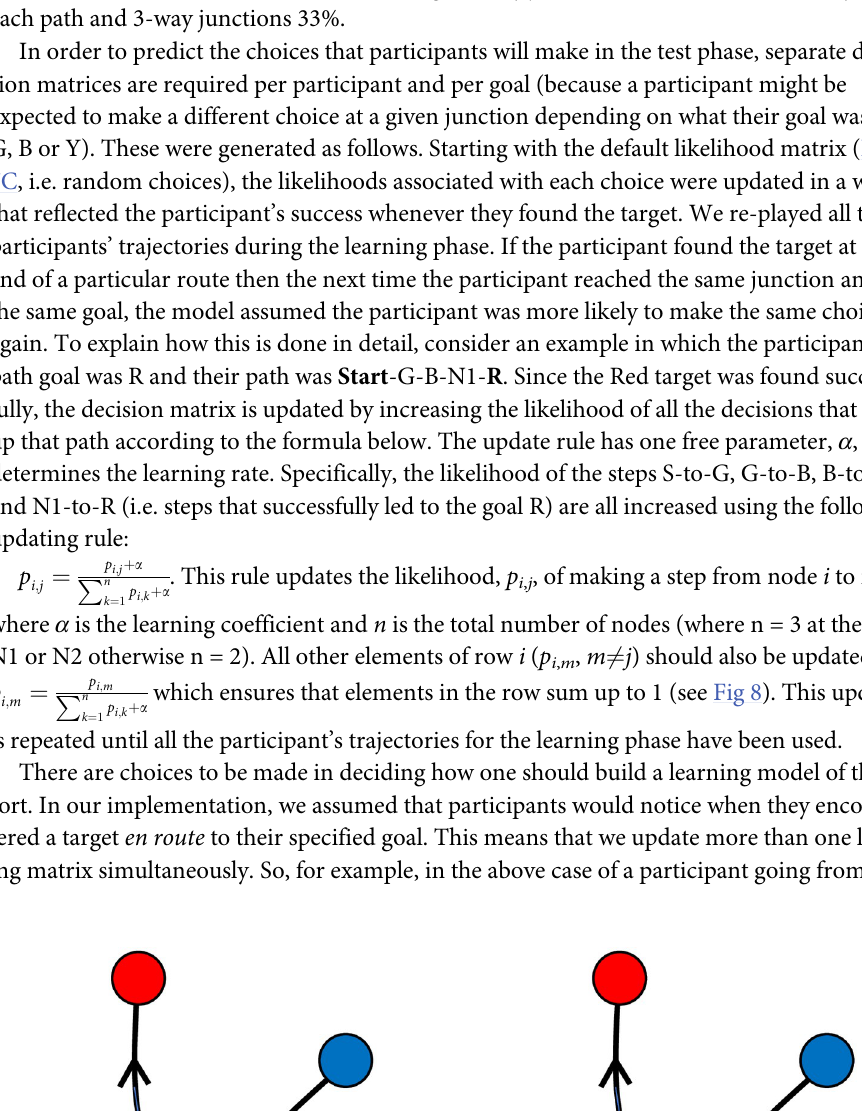
PLOS ONE | https://doi.org/10.1371/journal.pone.0247818 April 20, 2021 11 /